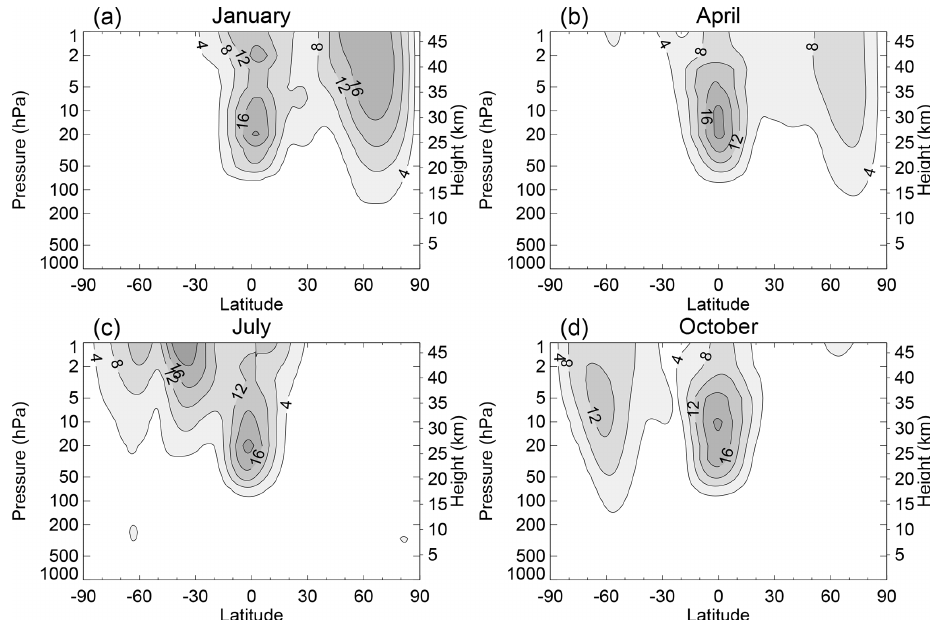
Figure 7. Interannual standard deviation of monthly and zonal mean eastward wind (ms − 1 ) for (a) January, (b) April, (c) July and (d) Octo- ber. Based on the same ERA5.1 reanalysis data (Hersbach et al., 2020) for 1979–2020 as used in Fig. 2. The contour interval is 4ms − 1 . The large interannual standard deviation in the low latitudes is a consequence of the QBO and is discussed further in Sect.